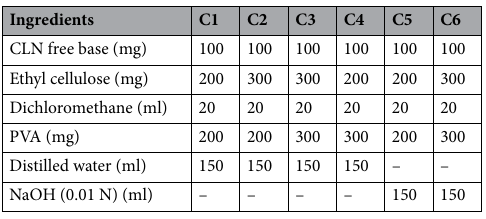
Table 1. Formulae for microsponges of CLN-free